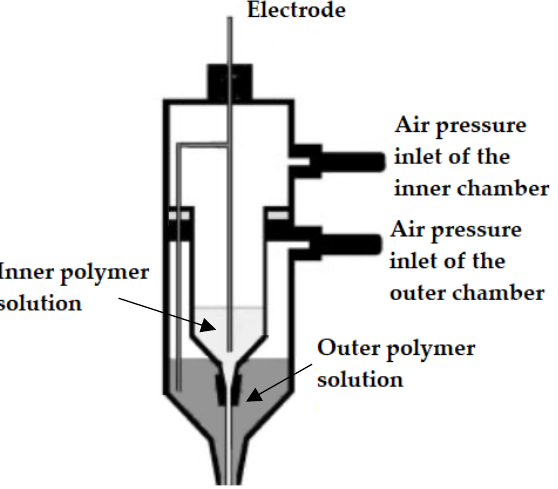
Figure 3. Original experimental set-up used for the first time in a coaxial electrospinning process (CES). Adapted with permission from [37] .